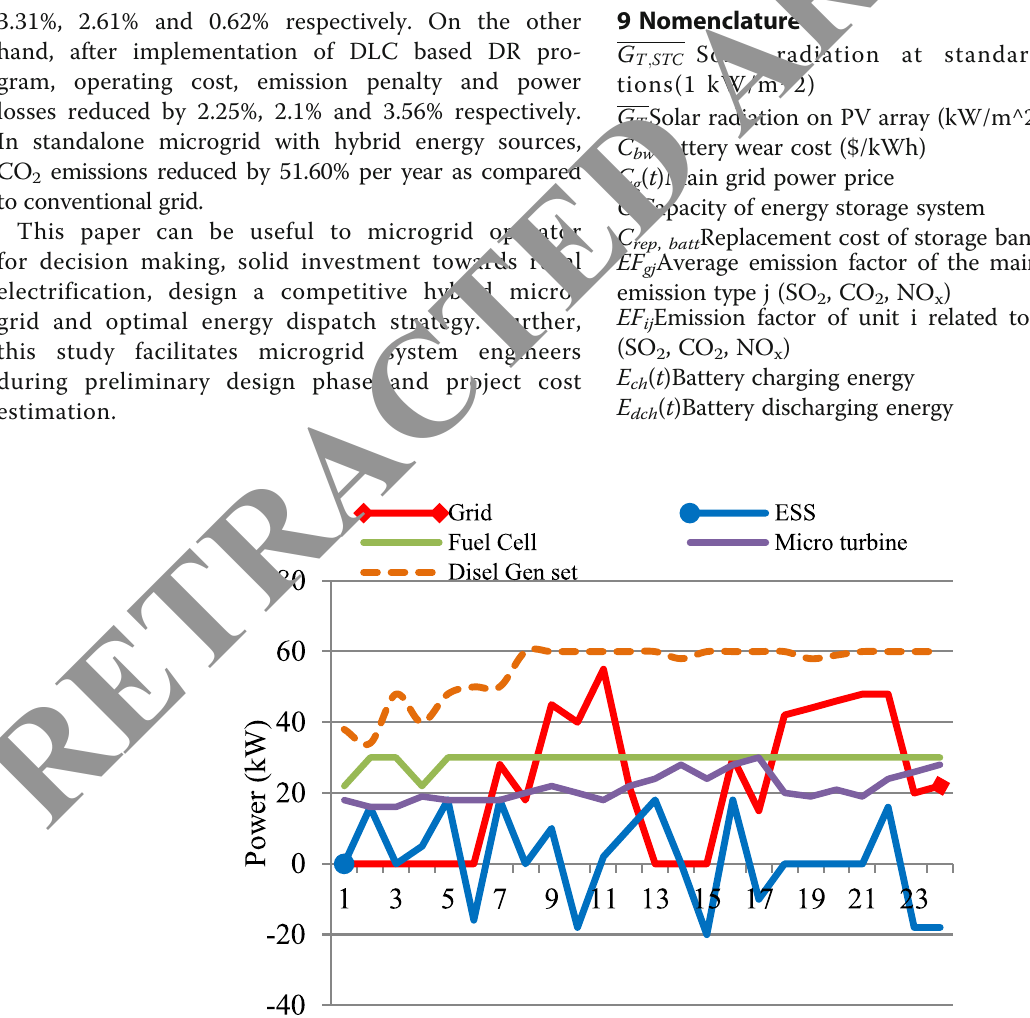
Fig. 11 Results for energy management using fuzzy